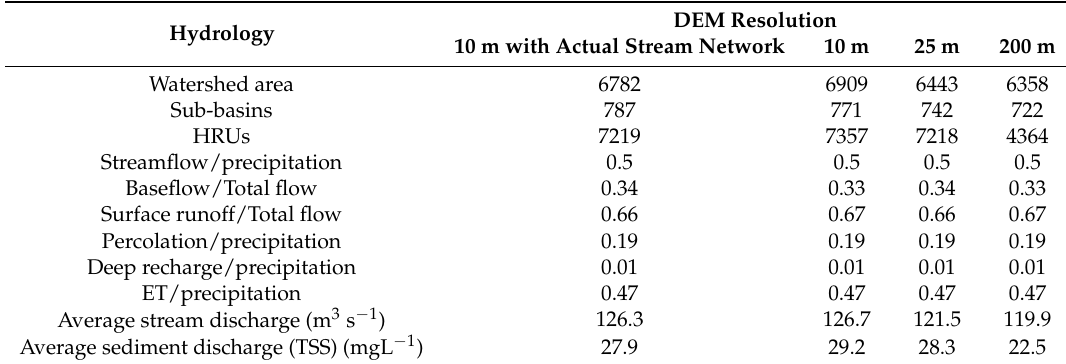
Table 4. Comparison of SWAT models constructed using different DEM resolutions, compared against a SWAT model constructed using a ground-truthed stream network and 10 m resolution. DEM Hydrology